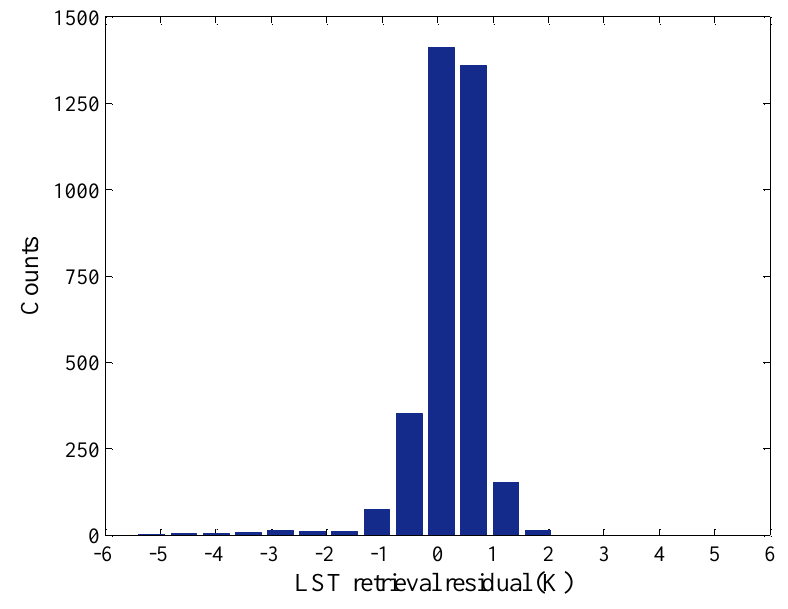
Figure 5. Histogram of the differences between the retrieved LST and the reference